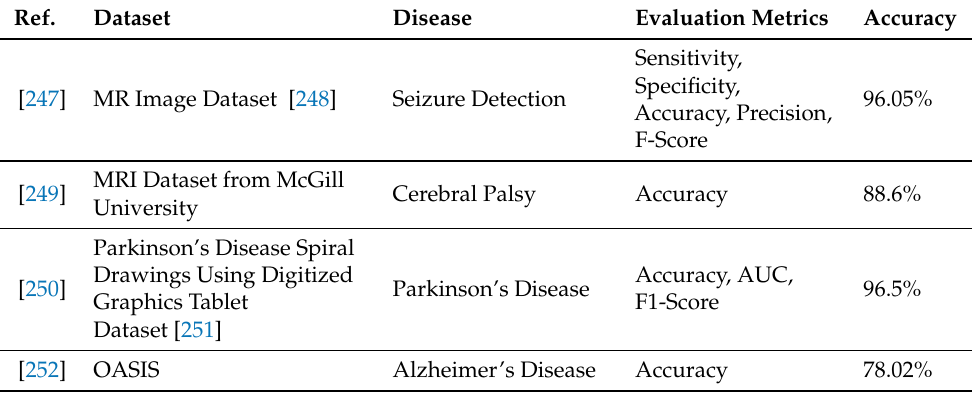
Table 14. CNN classifier result analysis on various NDs.